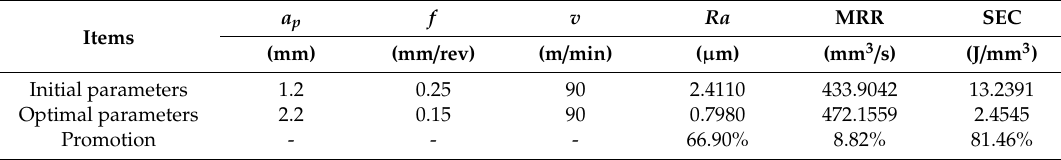
Table 8. Results with di ff erent cutting